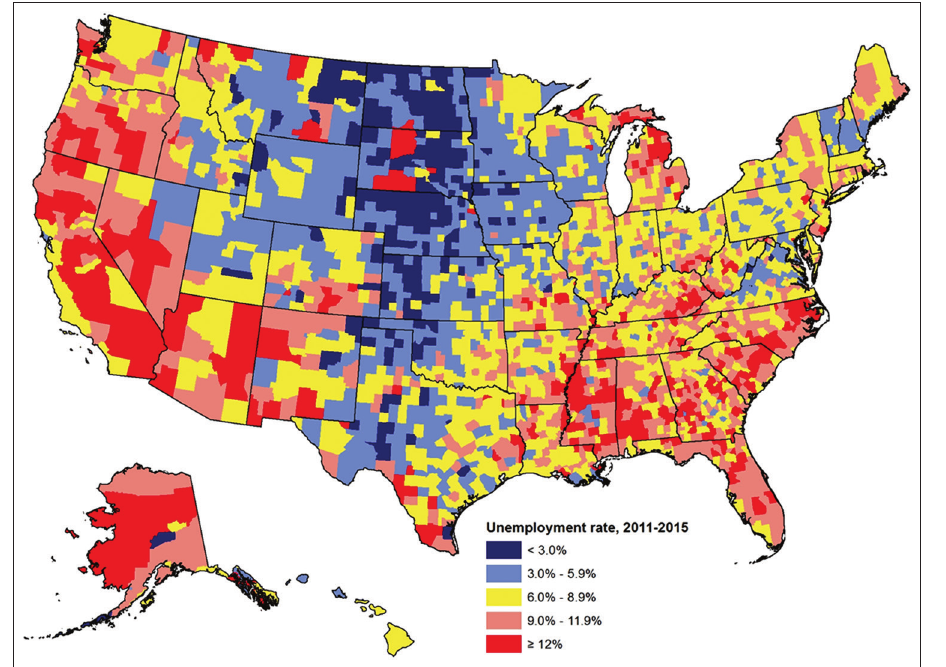
Fig ure 4. Unemployment Rate (Percentage of Civilian Labor Force that is Unemployed), United States, 2011-2015 (3,143 Counties) Source: Data derived from the 2011-2015 American Community